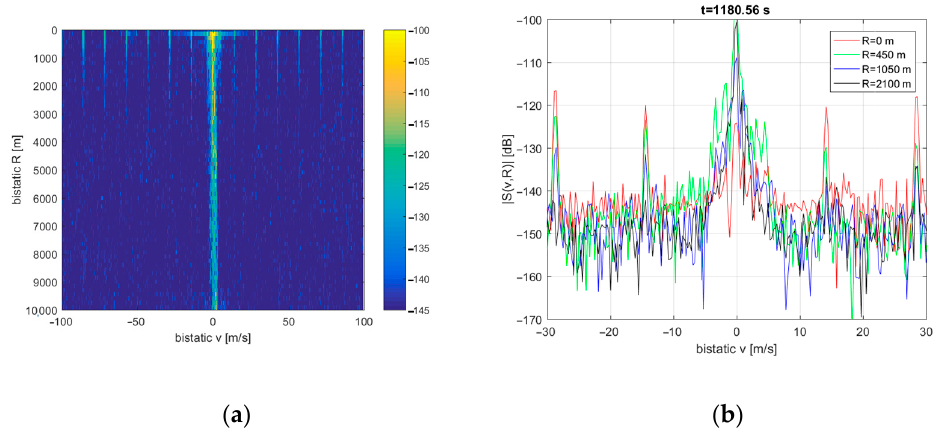
Figure 12. Clutter image during calm seas ( a ) and its cross-sections for selected bistatic ranges ( b ).